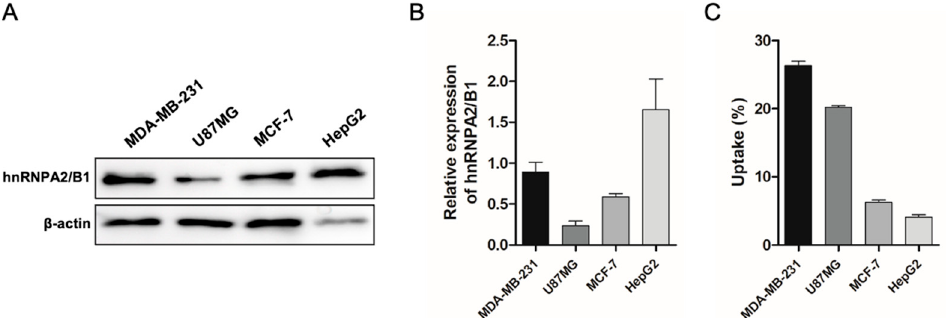
Figure 2. Representative Western blot analysis showing hnRNPA2B1 expression levels in four cancer cell lines using hnRNPA2B1-specific monoclonal antibody. β -actin was used as a loading control ( A ). Band densities were measured using ImageJ software ( n = 4) ( B ). Cellular uptake studies of the radioimmunoconjugate 64 Cu-PCB-hnRNP in different cancer cell lines ( C ).